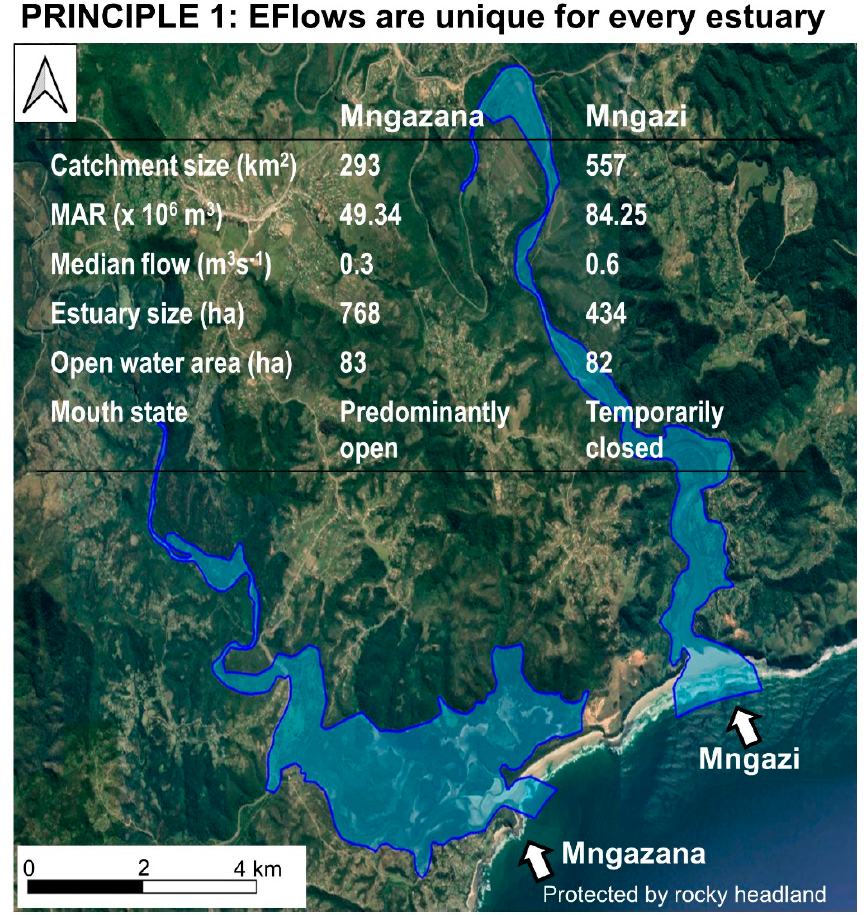
Figure 4. Characteristics of the predominantly open Mngazana Estuary compared to the temporarily closed Mngazi Estuary.